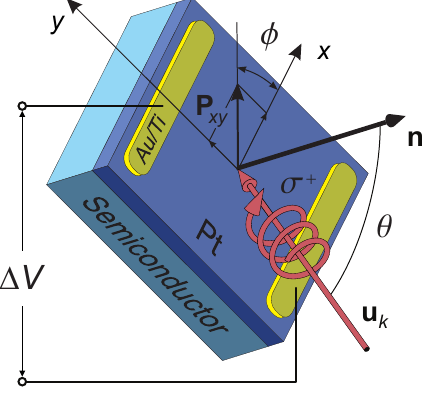
Figure 2. Scheme of the optical orientation/ISHE geometry in the case a Pt layer is deposited on top of the semiconductor (Ge or GaAs): θ is the angle between the direction of the incident light u k and the normal n to the sample, φ is the angle between the projection of u k in the sample plane and the x axis. The demodulated signal ∆ V is sensitive to the component of the spin polarization along the in-plane x